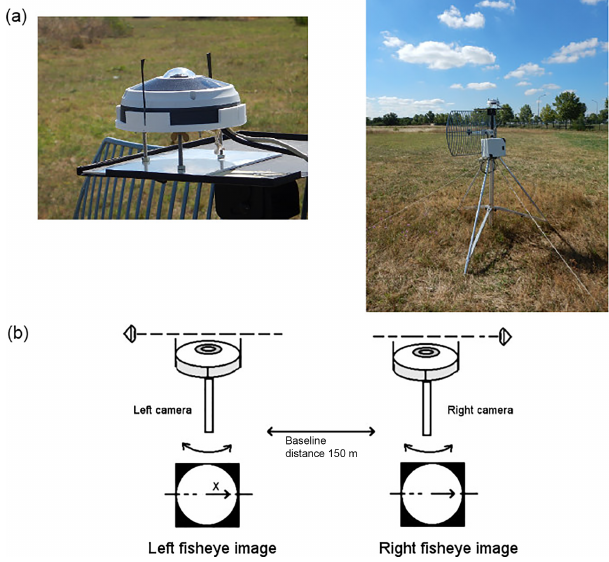
Figure 1. (a) VIVOTEK FE8391-V fisheye camera and installation structure. (b) Vertical sights on the camera housing allow visual inter-camera alignment in the horizontal